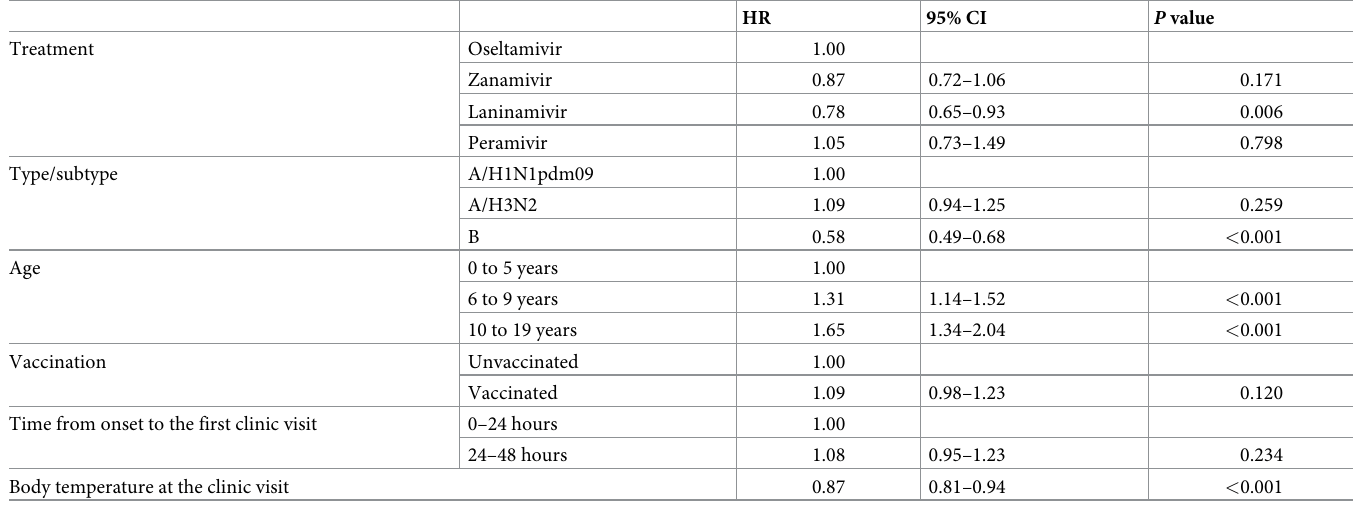
Table 4. Cox proportional hazards model of fever duration.